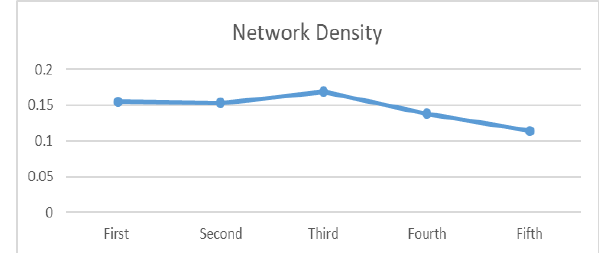
Figure 15. Network Density for network graph after grouping